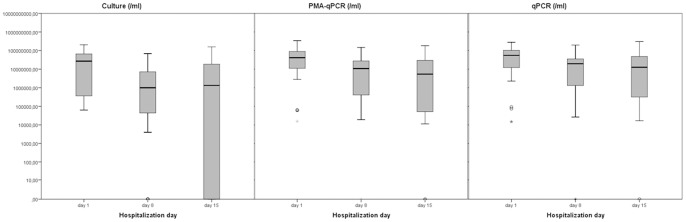
Median density (for 27 samples from 18 patients) of P. aeruginosa cells/ml sputum at hospitalization days 1, 8 and 15, as determined by the three quantification techniques, i.e. culture, qPCR and PMA-qPCR.*  =  statistically significant (p<0.05).